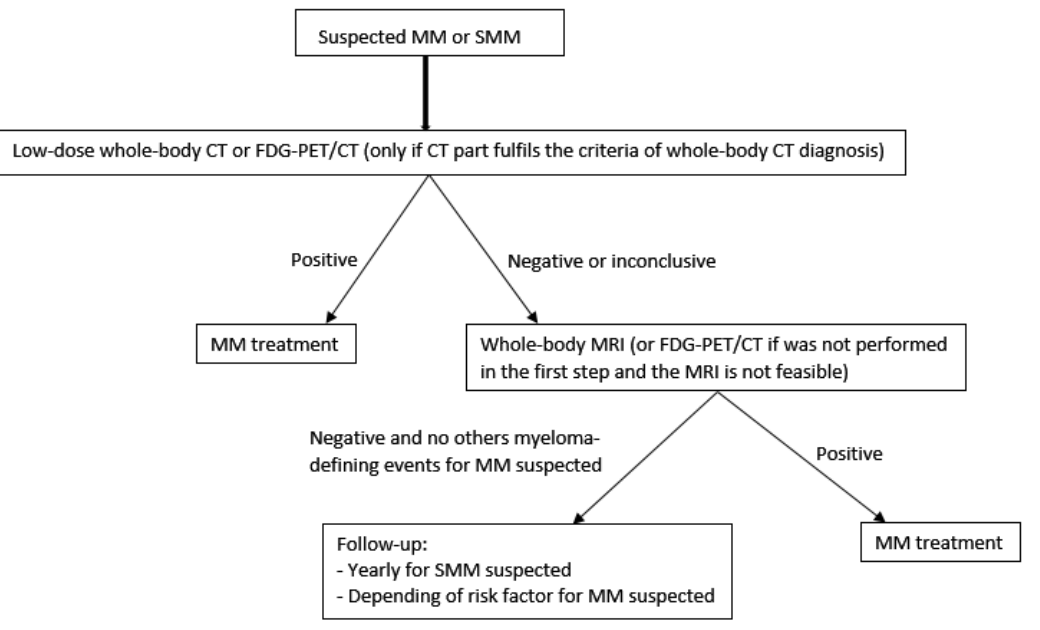
Figure 4. Imaging algorithm for MM and SMM suspected. CT: computerized tomography; MRI: magnetic resonance imaging; MM; multiple myeloma; SMM: smoldering multiple myeloma. Based on “Hillengass J, Usmani S, Rajkumar SV, Durie BGM, Mateos M-V, Lonial S, et al. International